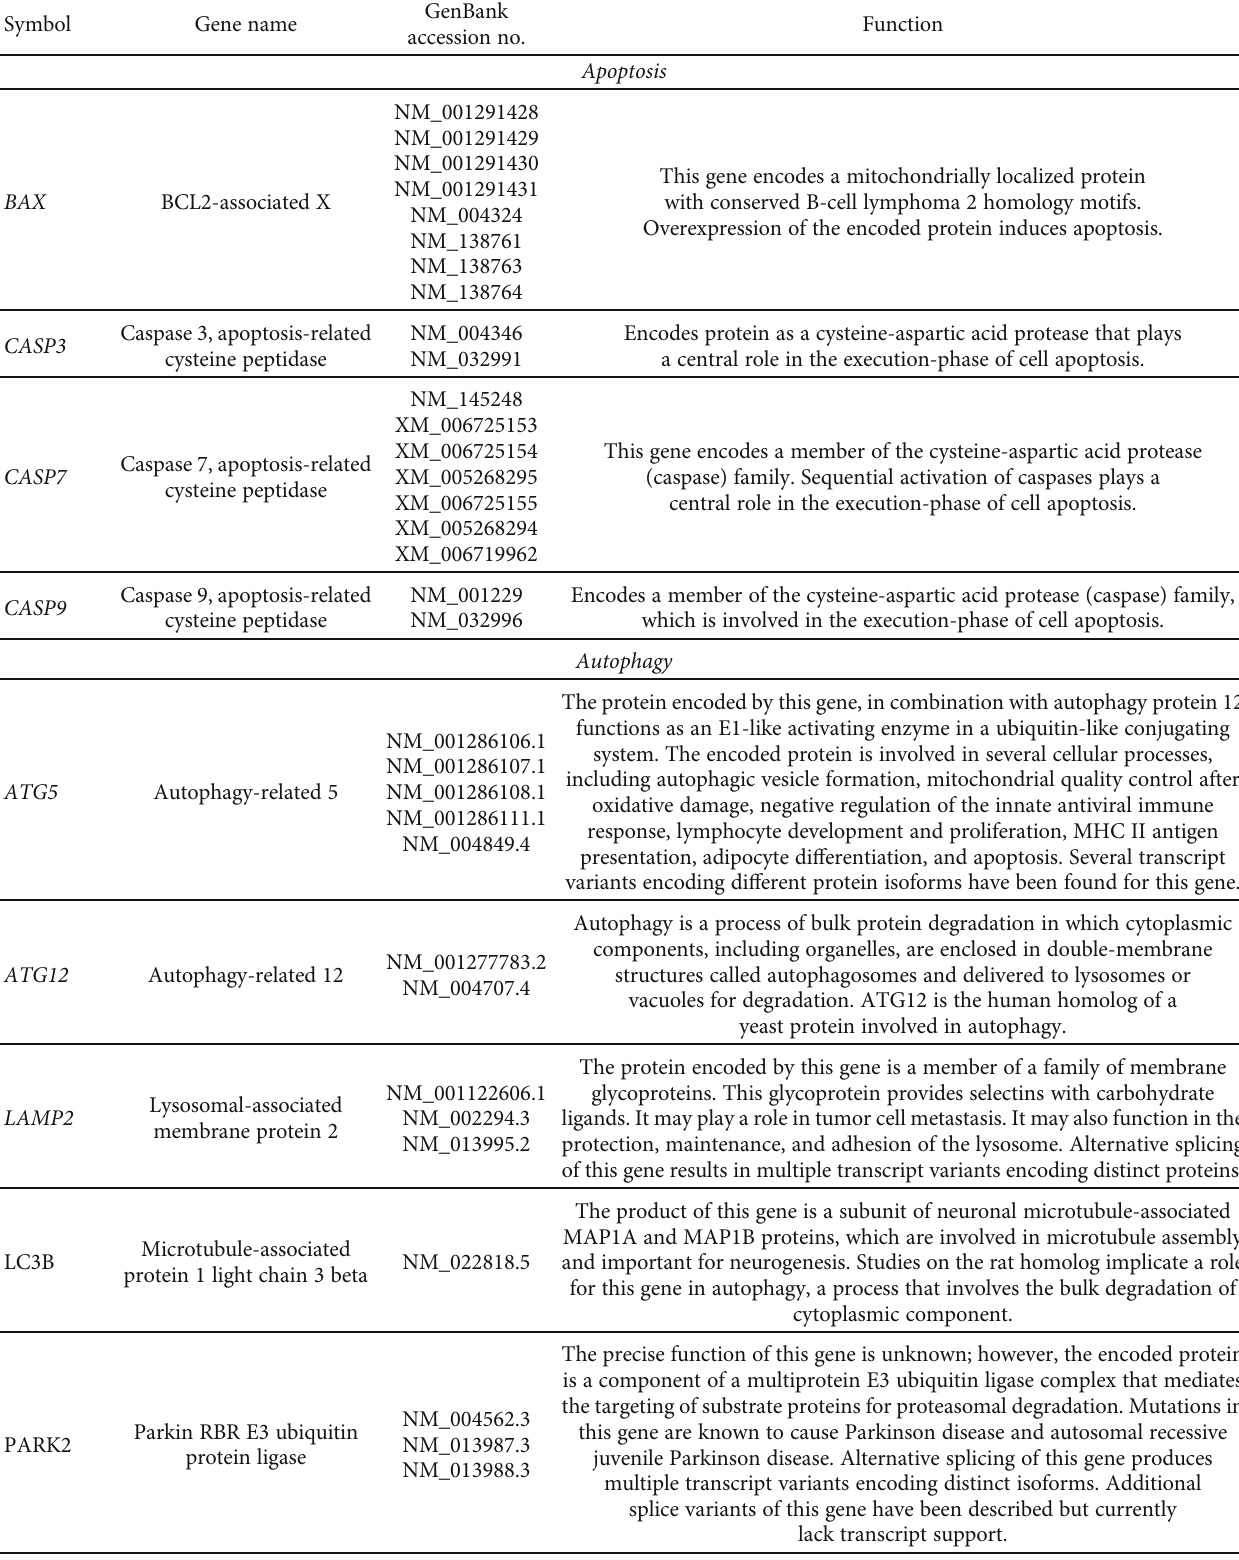
Table 2: Information of the genes related to apoptosis, autophagy, ER stress, and antioxidant genes analyzed in the AMD cybrids. Genes analyzed in the hRPCs represent the neuroprotective factors and markers of glial and neuronal lineage.